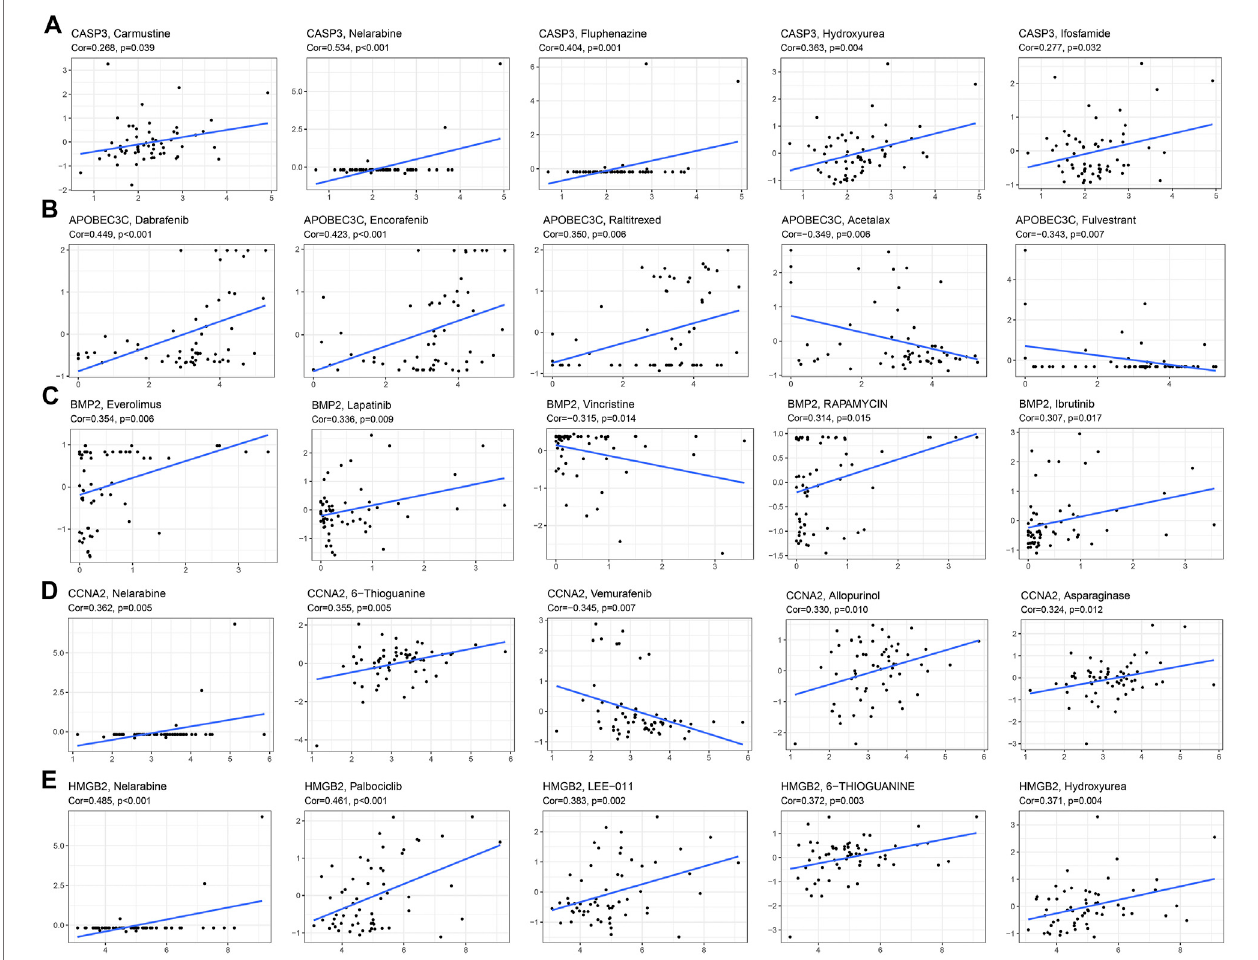
FIGURE 12 | Correlation analysis between 5 PR-DE-IRGs and the 5 drugs approved by the food and drug administration (FDA). (A) CASP3. (B) APOBEC3C. (C) BMP2. (D) CCNA2. (E) HMGB2.